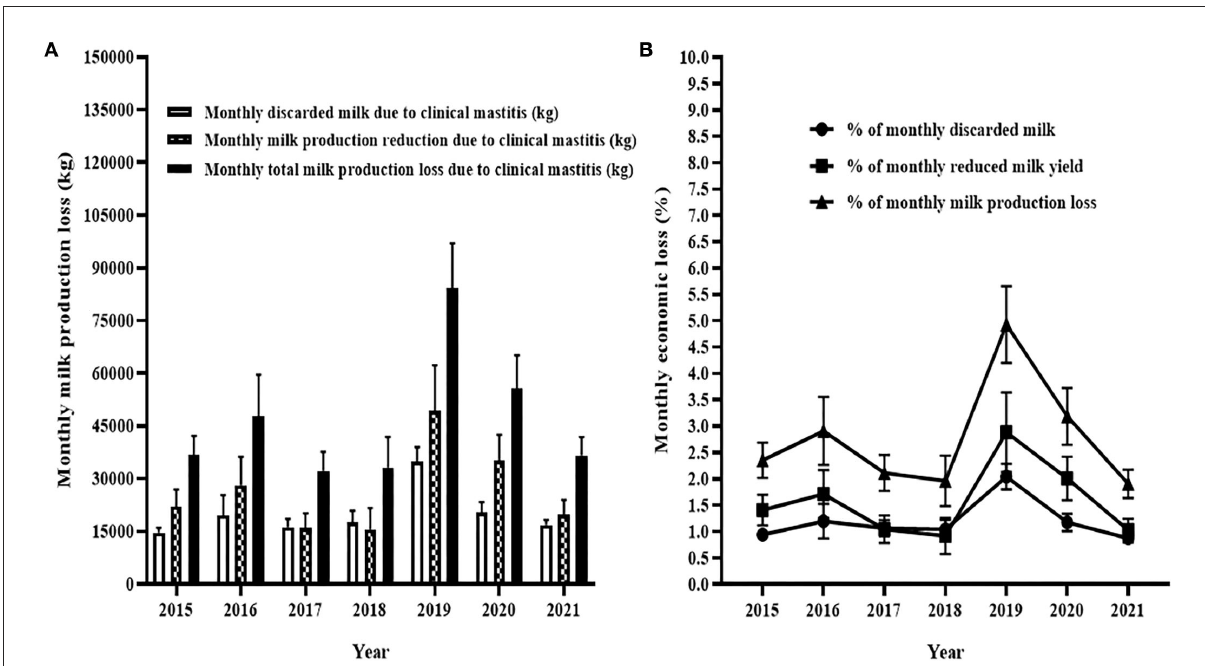
FIGURE7 Monthly milk production loss due to clinical mastitis. In (A) , unshaded solid bar with error represents mean and 95% CI of monthly discarded milk due to clinical mastitis while half-shaded solid bar with error indicates milk production loss due to reduction in milk yield of cows affected by clinical mastitis and shaded solid bar with error shows to mean of monthly total milk production in related to occurrence of clinical mastitis. Similarly, (B) shows the percentage of monthly discard milk, monthly reduction in milk production, and monthly total production loss due to clinical